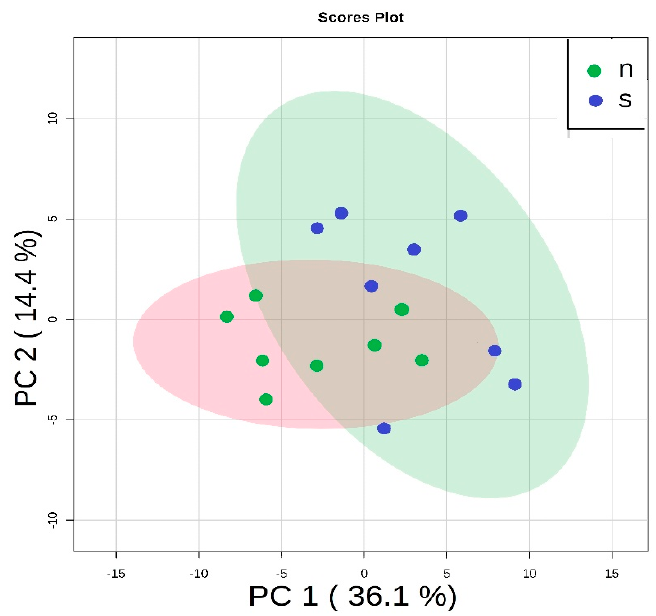
Figure 6. The principal component analysis performed on two groups—rats on the standard diet (blue dots—s) and rats with Zn NP supplementation (green dots—n). Both groups are clearly separated.